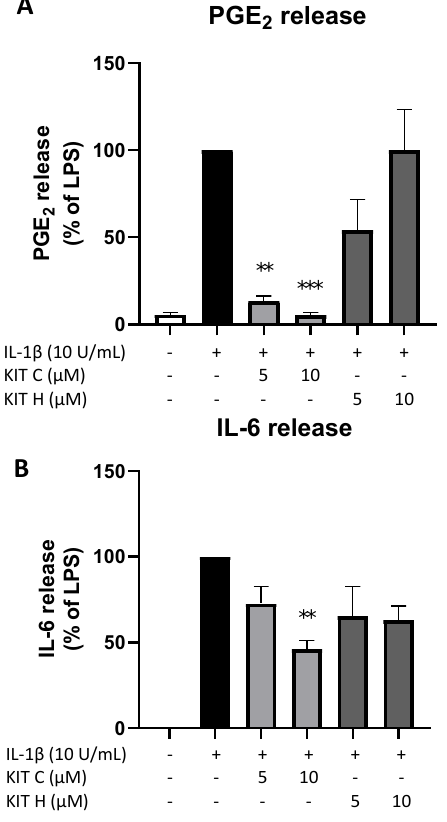
Figure 8. Effects of KIT C (light grey bars) and KIT H (dark grey bars) on PGE 2 - ( A ) and IL-6-synthesis ( B ) in LPS-stimulated primary mice microglia. Cells were stimulated as described under material and methods. After 24 h of stimulation, supernatants were collected and the release of PGE 2 or IL-6 was measured by EIA/ELISA. Values are presented as the mean ± SEM of at least three independent experiments. Statistical analysis was performed using one-way ANOVA with Dunnett’s post hoc tests with ** p < 0.01 and *** p < 0.001 compared to LPS.